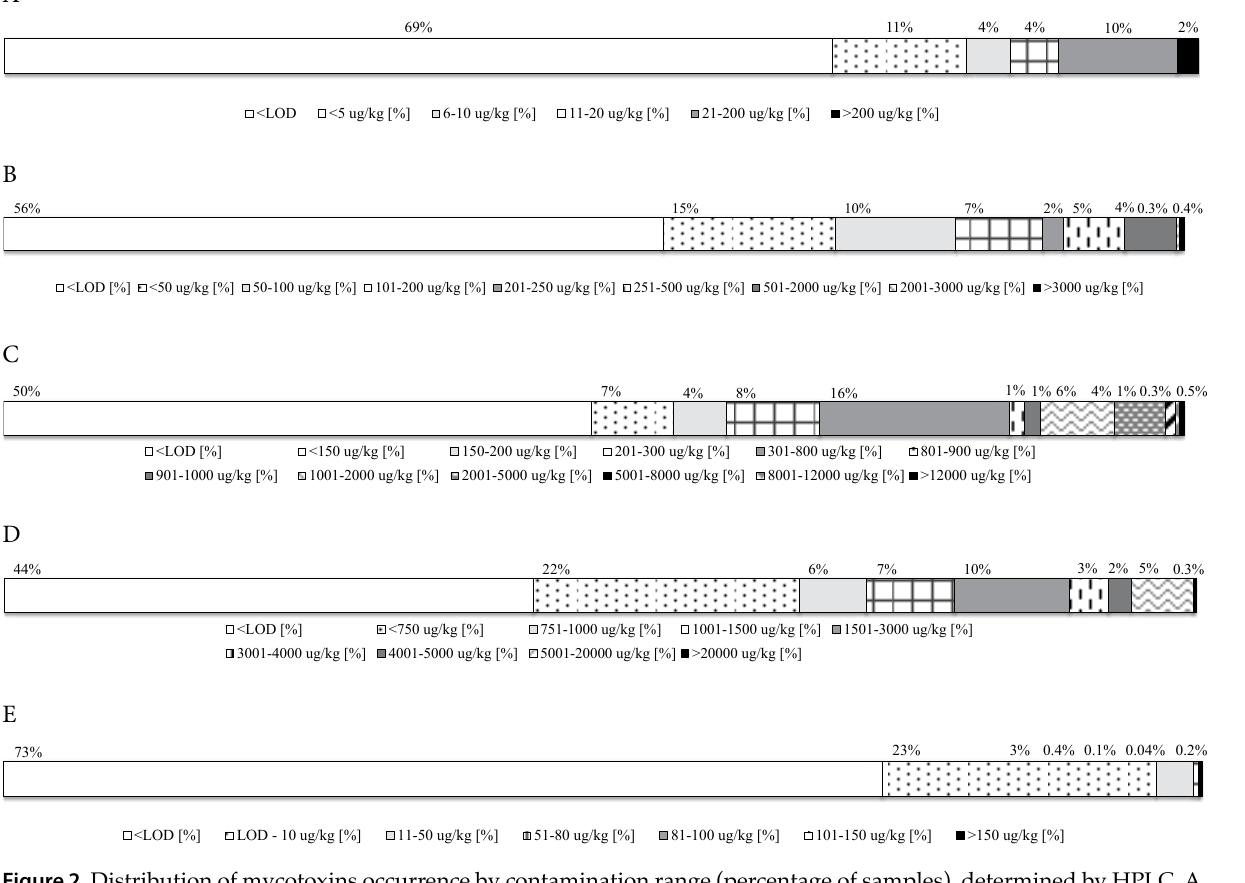
Figure 2. Distribution of mycotoxins occurrence by contamination range (percentage of samples), determined by HPLC. A, Afla; B, ZON; C, DON; D, FUM; E,